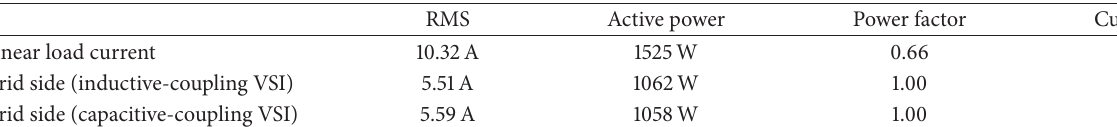
Table 4: Simulation results without harmonics compensation.